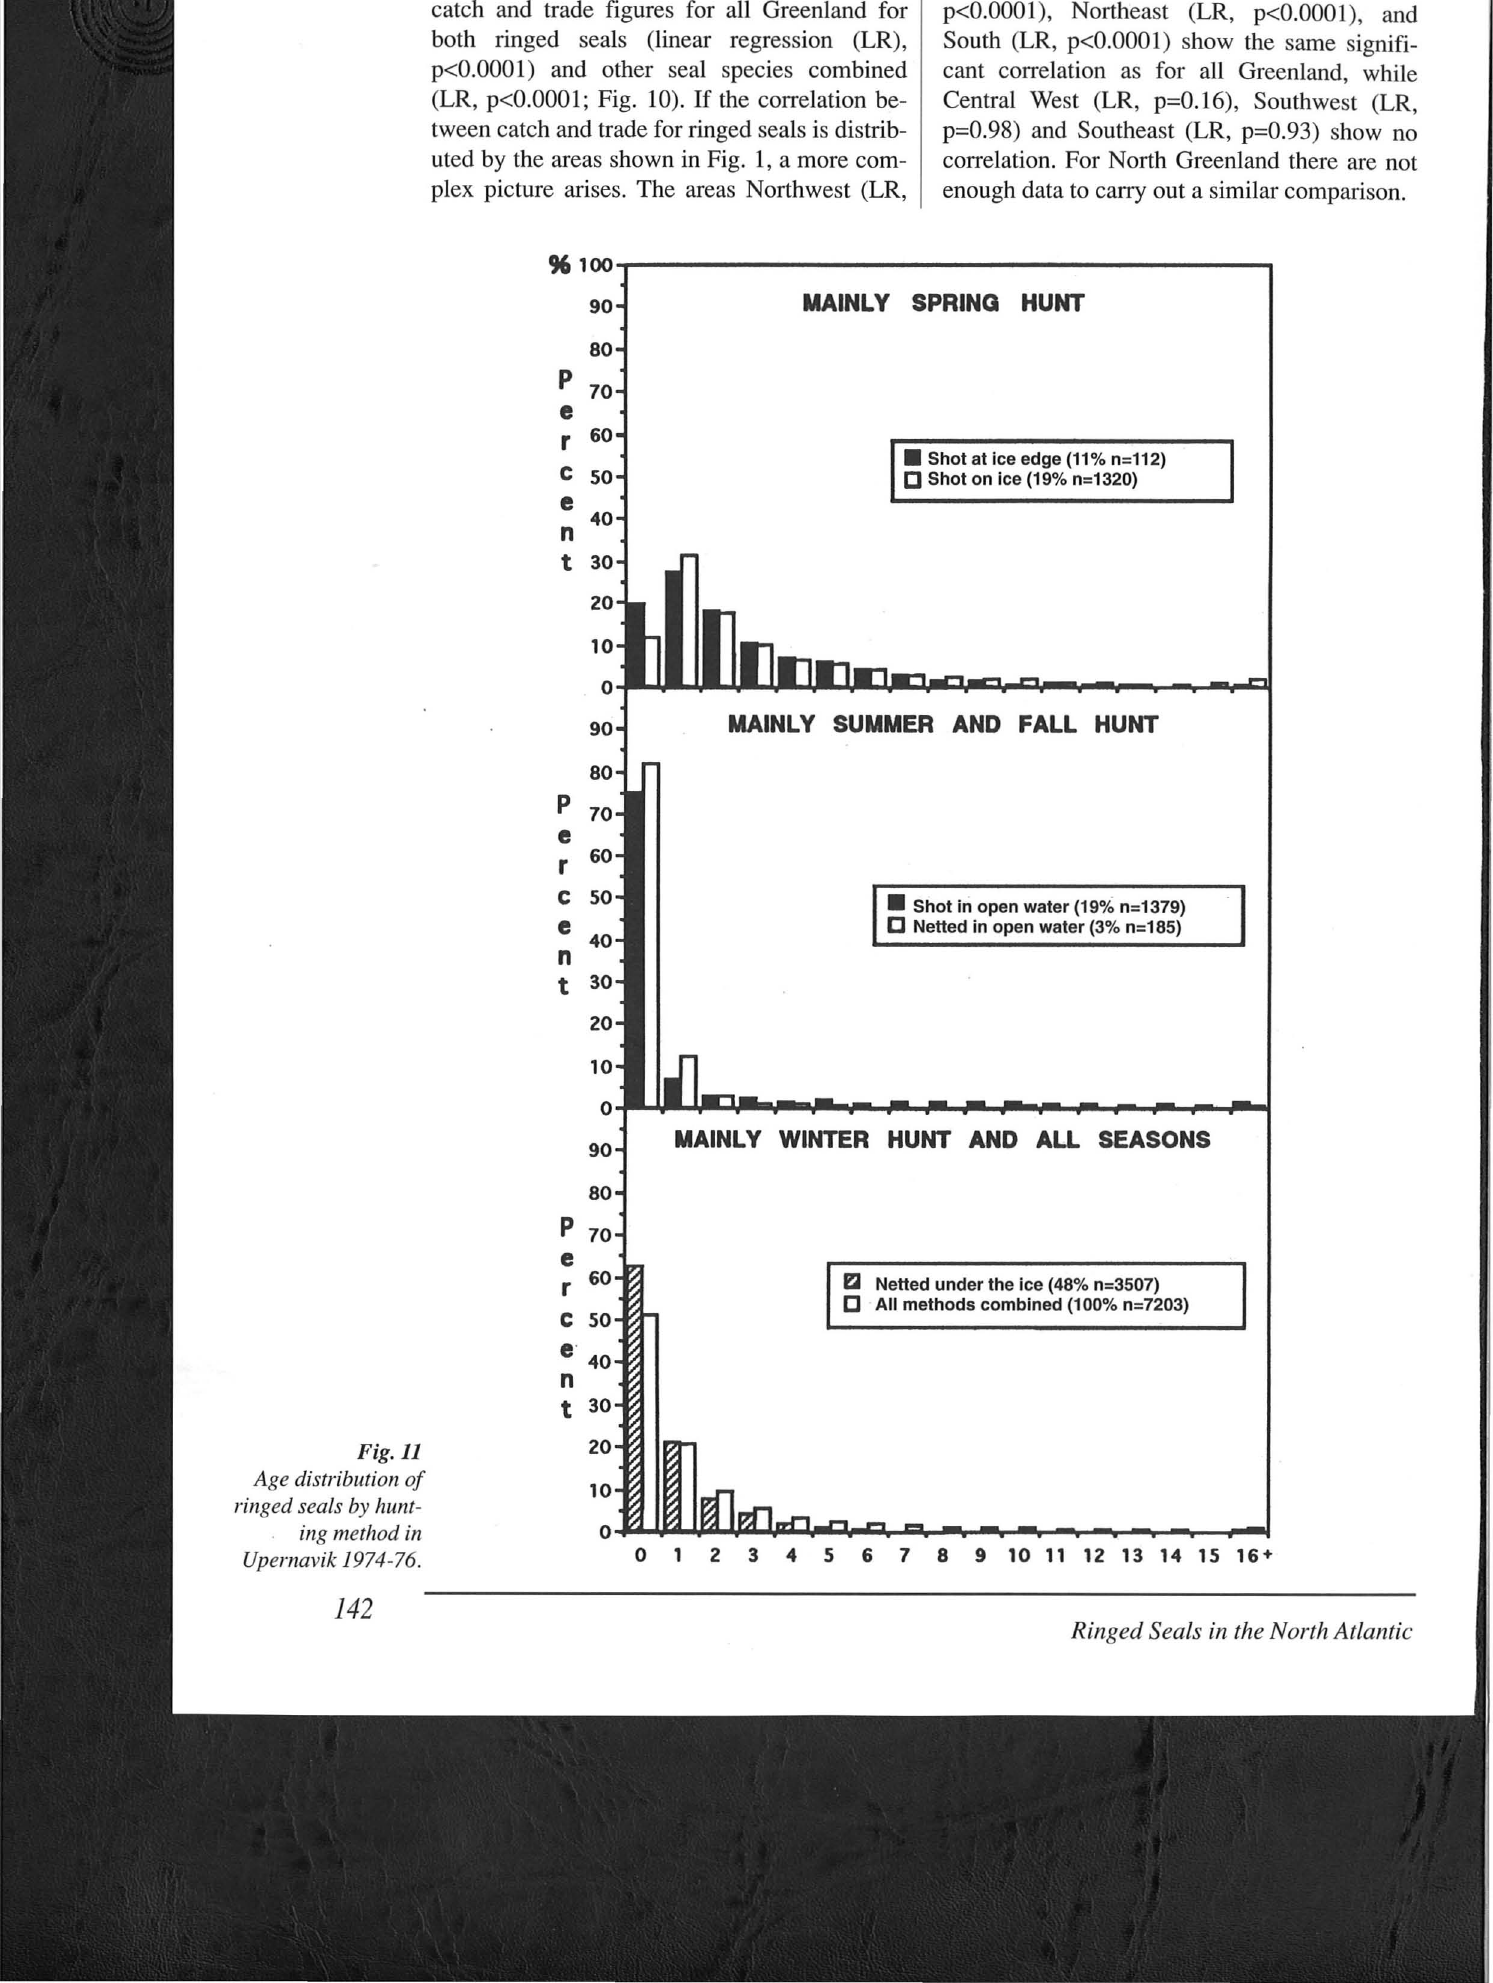
Age distribution of ringed seals by